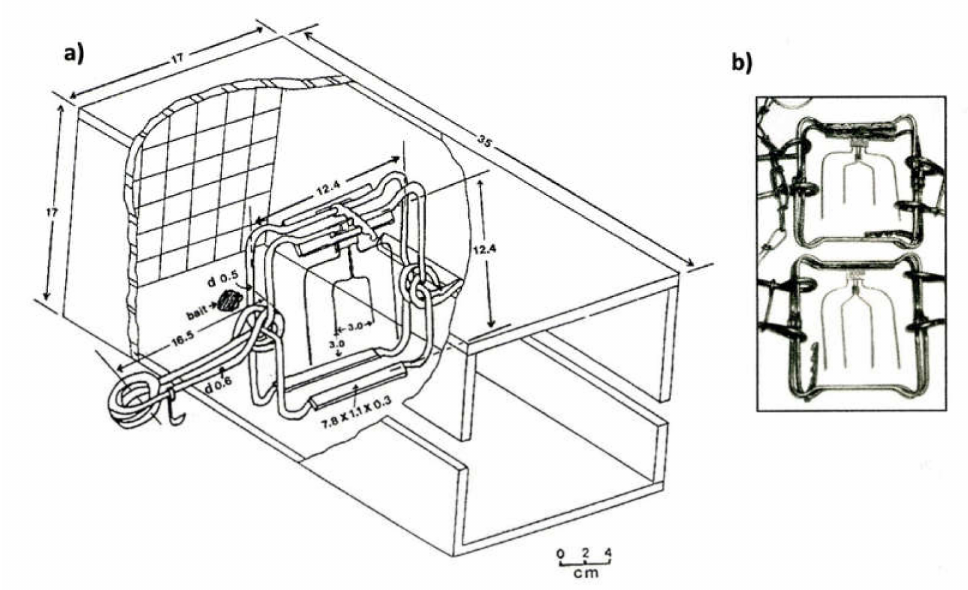
Figure 1. The ability of the C120 Magnum rotating-jaw trap to render American martens irreversibly unconscious in ≤ 3 min in compounds [34] and on traplines [36] was tested with a four-prong trigger and a specific cubby box ( a ) [60]. The trigger has two short centre prongs to properly position the animals in the traps and ensure a strike in vital regions [60]. When the original trigger was replaced with a four-long-prong trigger ( b ), the trap did not properly strike animals in the head [34] and was not as capture-e ffi cient